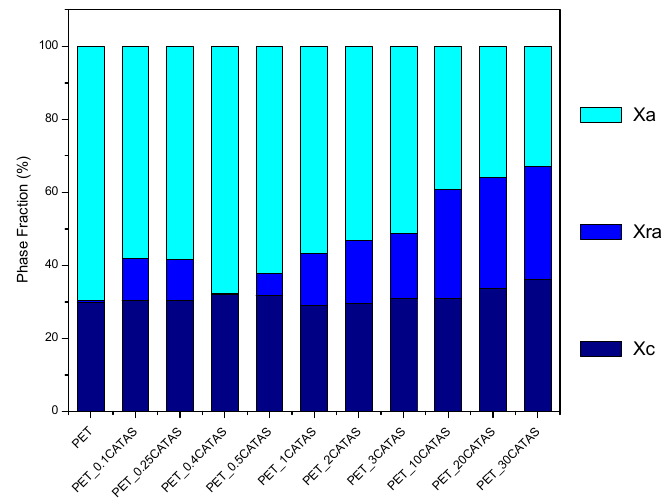
Figure 9. Evolution of different phase fractions for rPET and rPET_CATAS content.